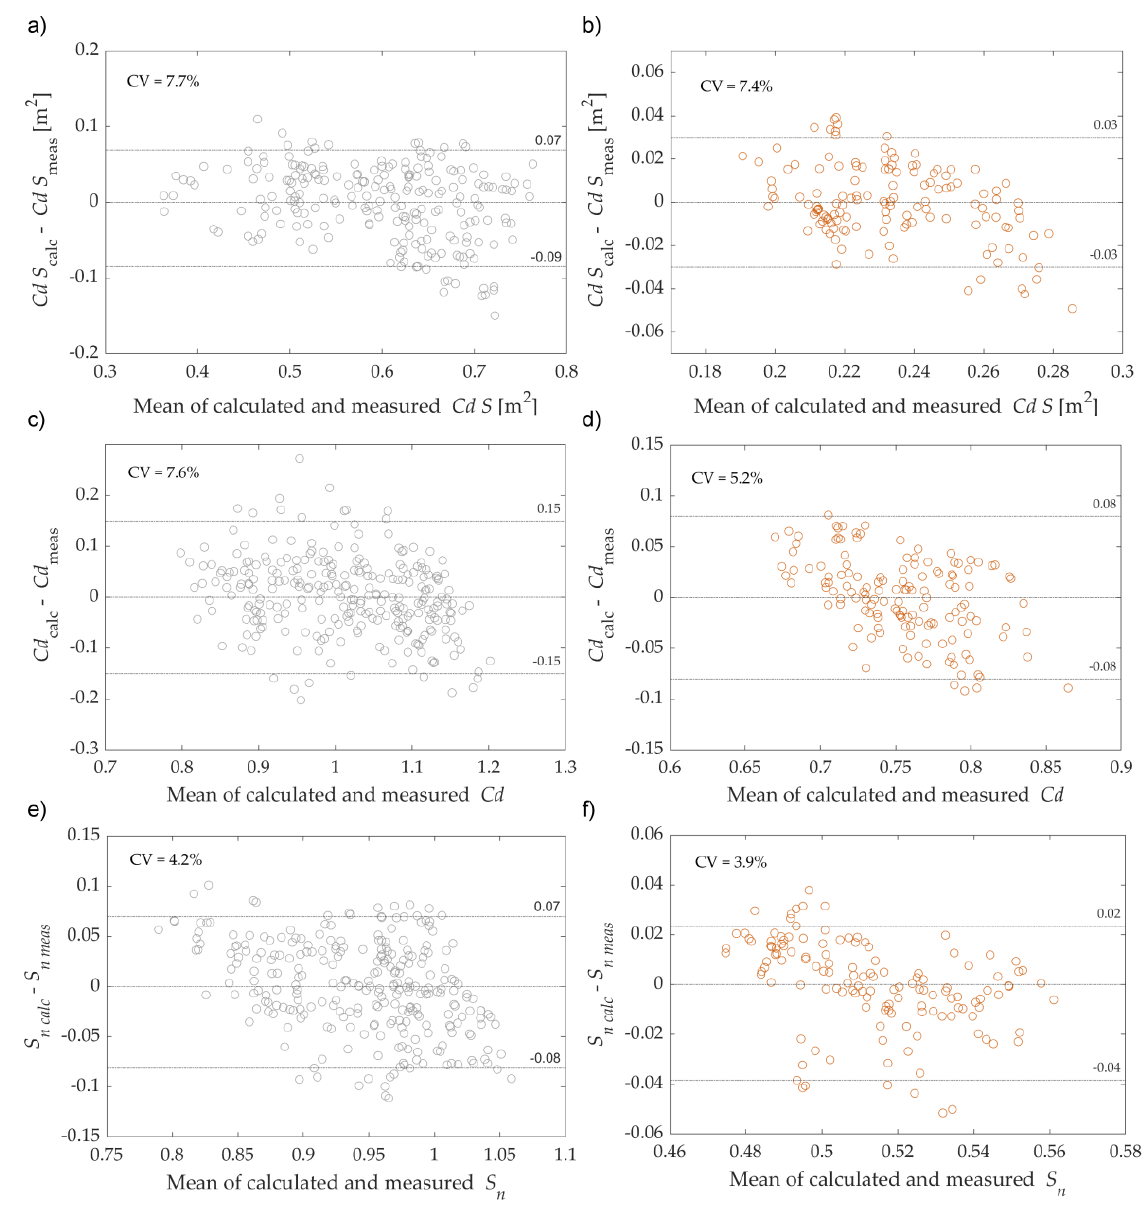
Figure 4. Bland–Altman plots demonstrating the mean differences between the calculated and measured values for the three parameters of interest. ( a , b ): product of the coefficient of aerodynamic drag and cross-sectional area (C d · S), ( c , d ): coefficient of aerodynamic drag (C d ), and ( e , f ): the normalized cross-sectional area (S n ). The diagrams on the left ( a , c , e ) depict these differences in the high and middle positions, while those on the right ( b , d , f ) are for the downhill (tuck) position. The dashed lines represent the limits of agreement. CV = coefficient of variation.